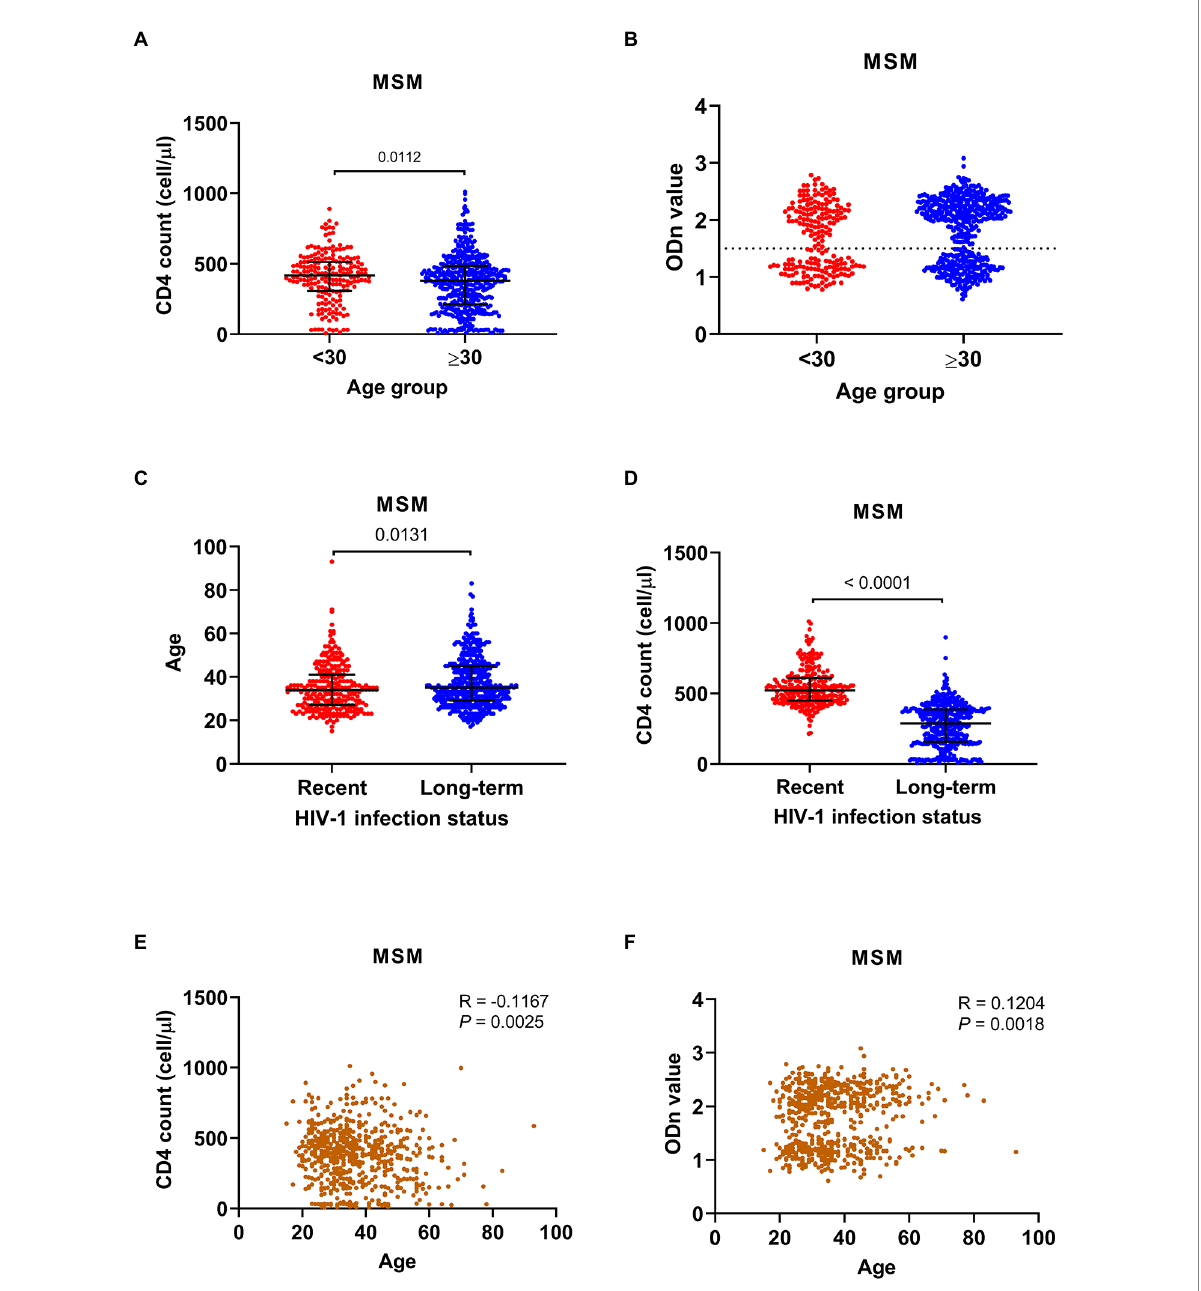
FIGURE 2 Comparison analyses between age groups and HIV-1 infection status groups of men who have sex with men (MSM). (A) The CD4 cell count in cases aged < 30 years and those aged ≥ 30 years. (B) The normalized optical density (ODn) value of plasma samples from cases aged < 30 years and cases aged ≥ 30 years in Limiting-Antigen Avidity assays. (C) The ages of MSM with recent and long-term HIV-1 infections. (D) The CD4 cell count of MSM with recent and long-term HIV-1 infections. (E,F) Correlation analyses between age and CD4 cell count and ODn value. Data in (A–D) were shown as median with interquartile range, and the comparison across groups was done by Kruskal–Wallis test. The correlation analyses in (E,F) were done by nonparametric Spearman correlation